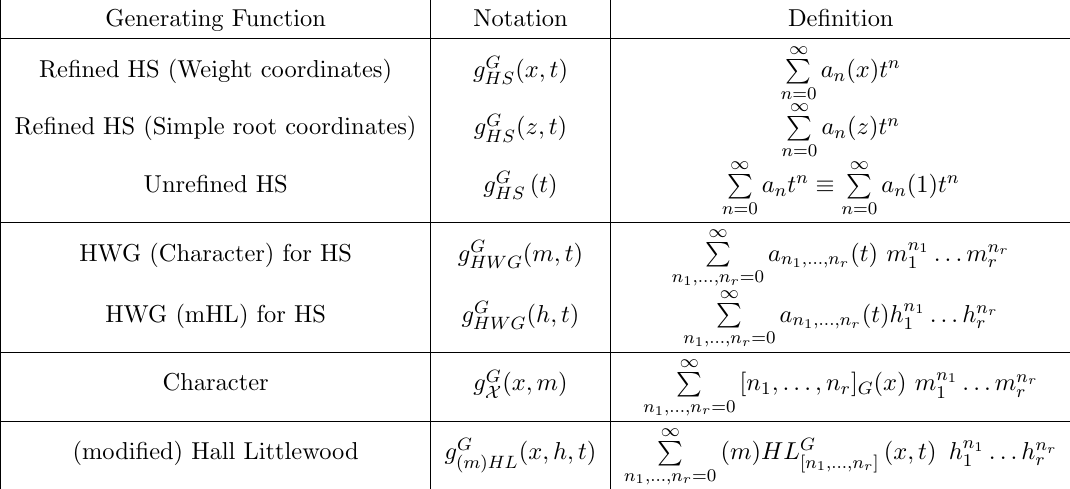
Table 1 . Types of generating